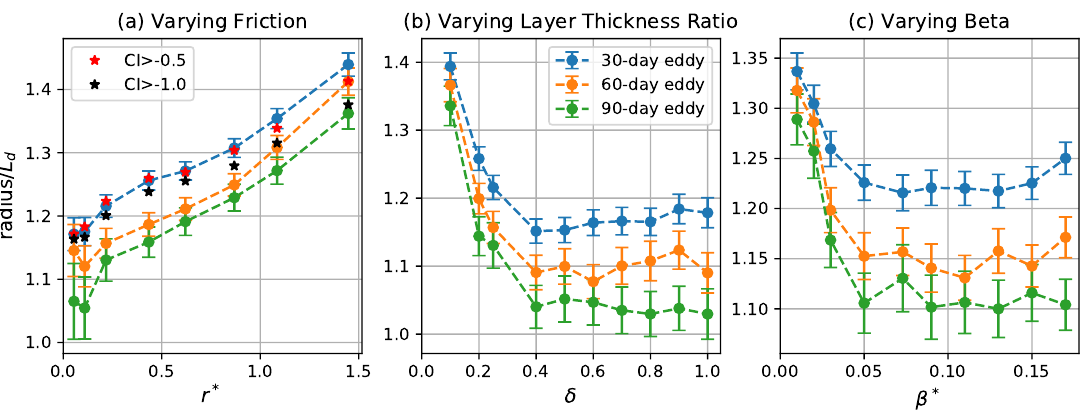
Figure 7. Radius of coherent eddies as a function of ( a ) r ∗ , ( b ) δ , and ( c ) β ∗ . Blue, orange, and green curves correspond to the mean of the radius for 30-, 60-, and 90-day eddies, respectively. Error bars give two times the standard error of the mean. Red and black stars in the left panel indicate the mean for 30-day eddies detected by varying the CI threshold to − 0.5 and − 1.0, respectively. Longer-lived coherent eddies have smaller coherent cores for all parameter values. This is because longer-lived coherent eddies are subsets of shorter-lived coherent eddies and particles near the outer edge are more likely to be lost as the eddy interacts with other eddies and the exterior straining flow. A given 90-day eddy begins life as a larger 30-day eddy and gradually loses particles, becoming a smaller 60-day eddy, and, finally, a still smaller 90-day eddy. Only the particles retained for the full 90 days are labeled as “belonging” the 90-day eddy, and these particles are closer to the eddy center than those retained for only 30 or 60